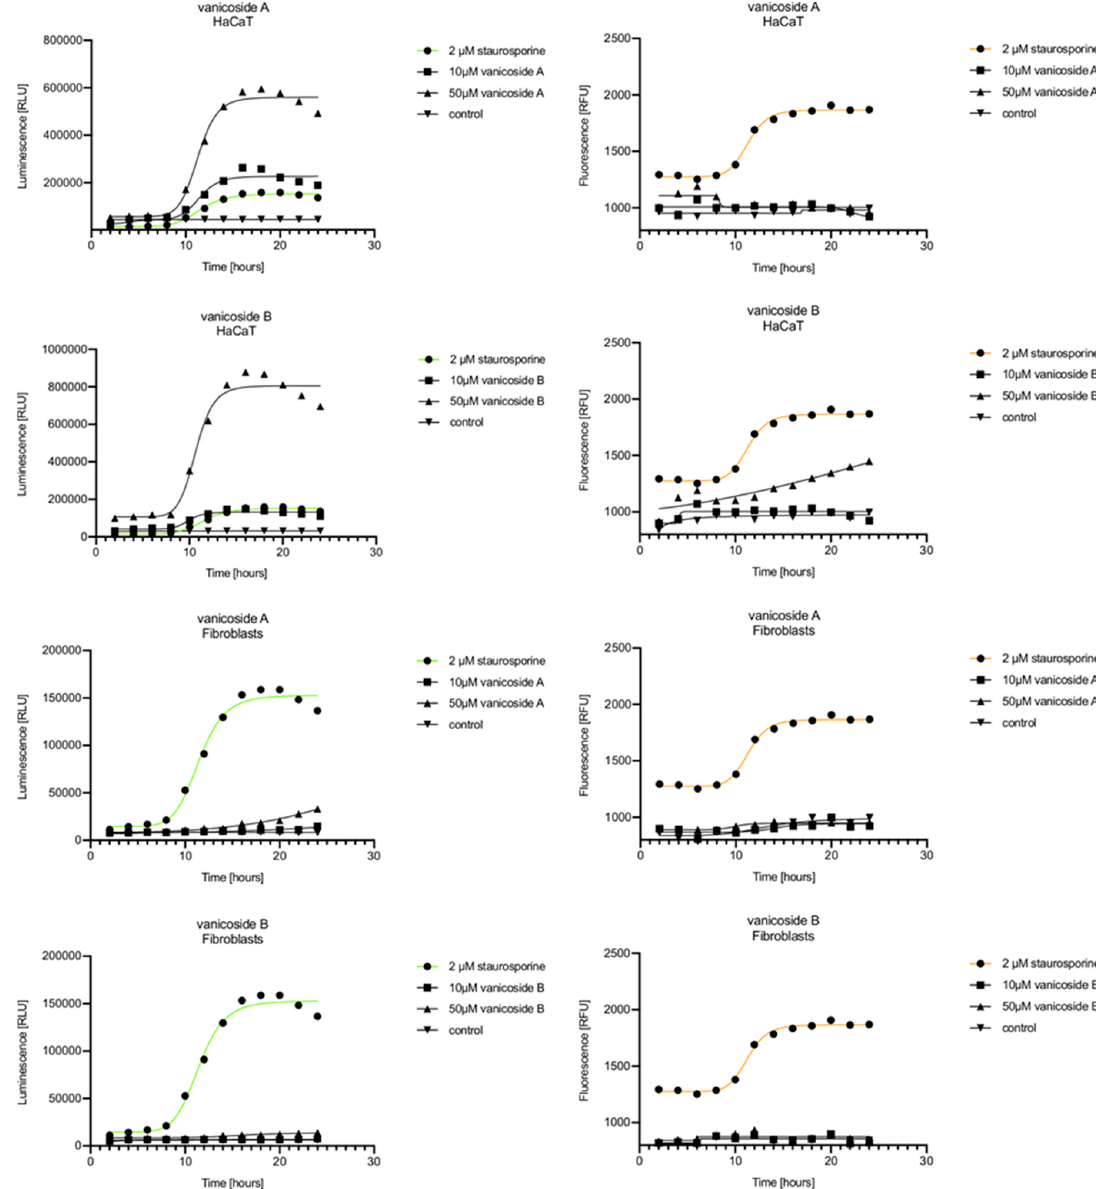
Figure 6. Real-time monitoring of luminescence (A) and fluorescence (B) signals measured for HaCaT and fibroblast cell lines treated with 10 and 50 µM of vanicoside A and vanicoside B over 24 h, reported in relative luminescence units (RLU) and relative fluorescence units (RFU), respectively. Staurosporine (2µM) was used as the positive control – an apoptosis-inducer. The term “control” means cell lines without treatment of vanicosides. Negative control for staurosporine was not presented.